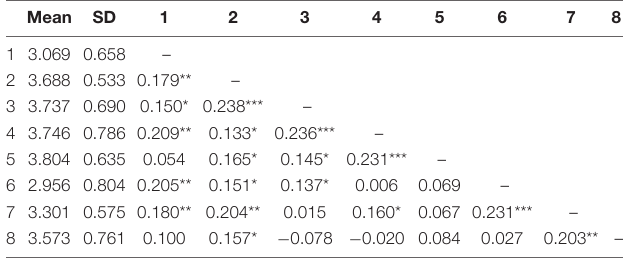
TABLE 1 | Results of correlation